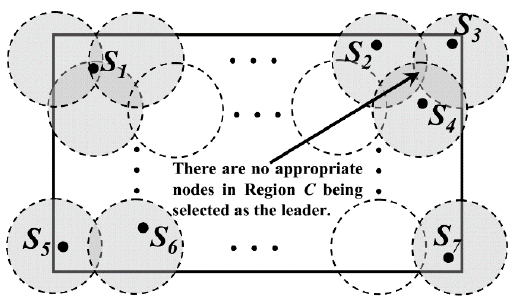
Figure 6. Leader nodes selection in each DGA.